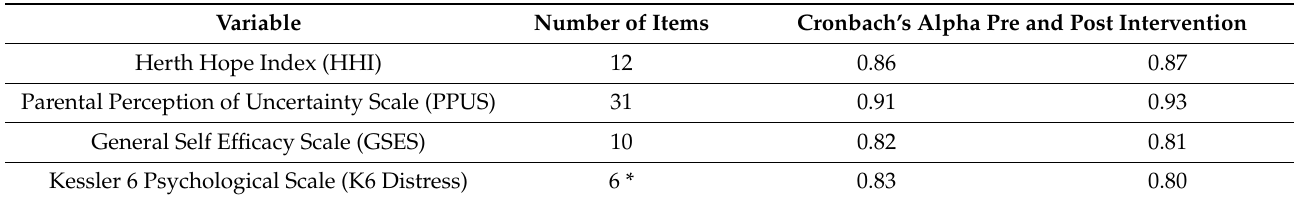
Table 1. Description of the Variables.